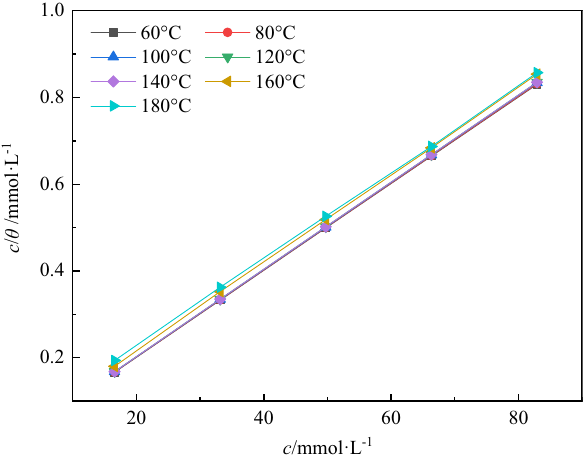
Figure 9: Curves fi tting of the corrosion data for steel at di ff erent